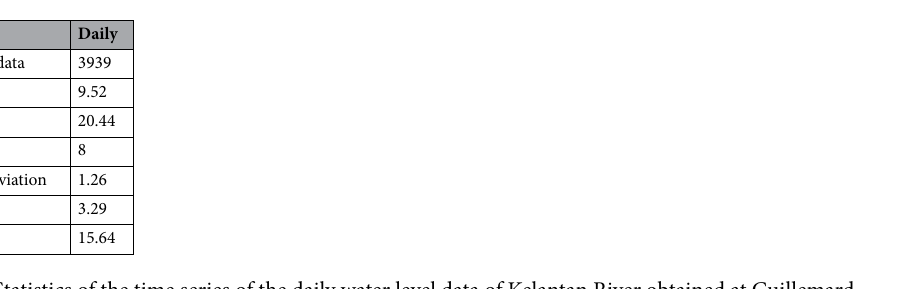
Table 1. Statistics of the time series of the daily water level data of Kelantan River obtained at Guillemard Bridge station from 01/01/2000 to